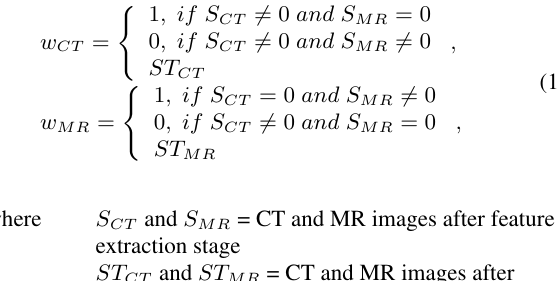
Figure 1. The general scheme of the medical image fusion method